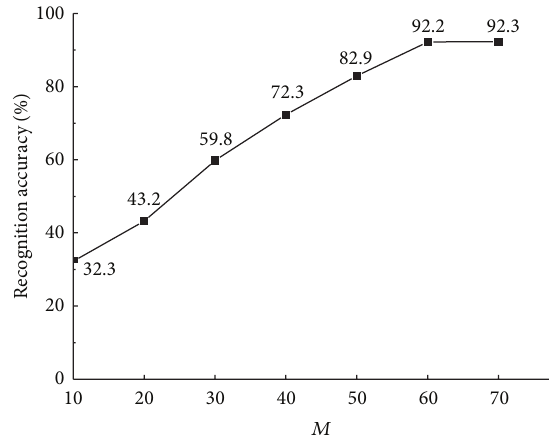
Figure 6: Relation curve between 𝑀 and